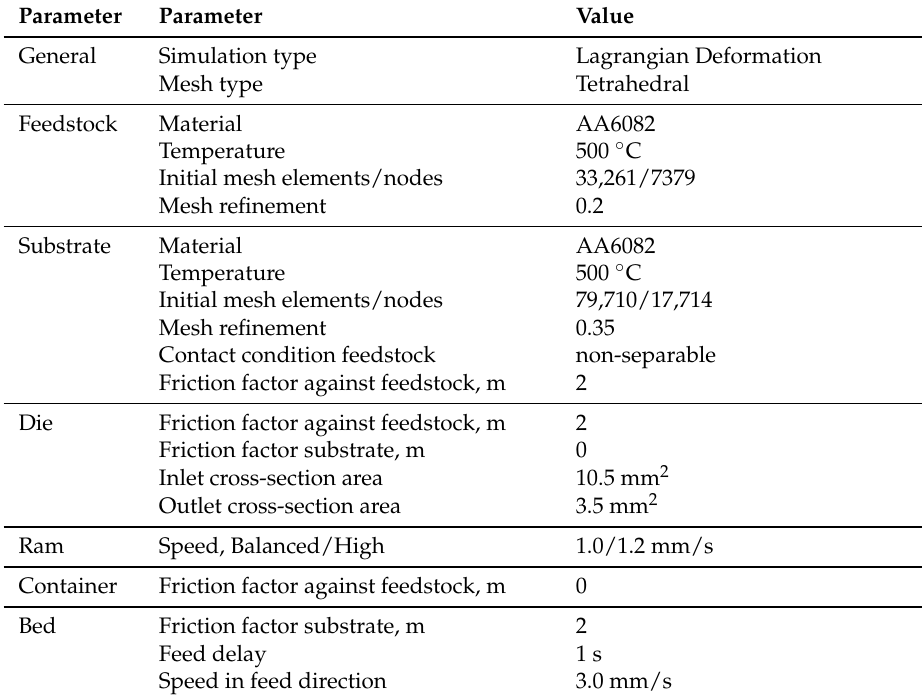
Table 2. Parameters used in FEM-model